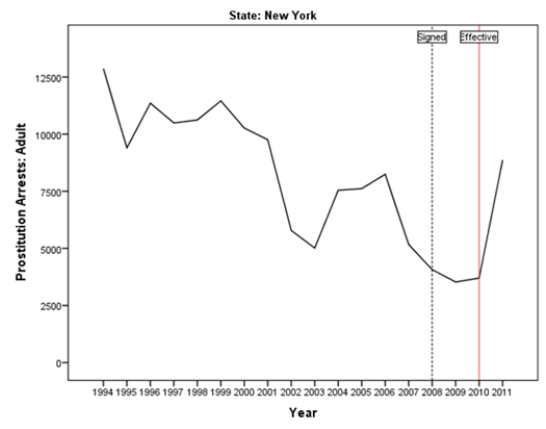
Figure 2. Adult prostitution arrests: New York.